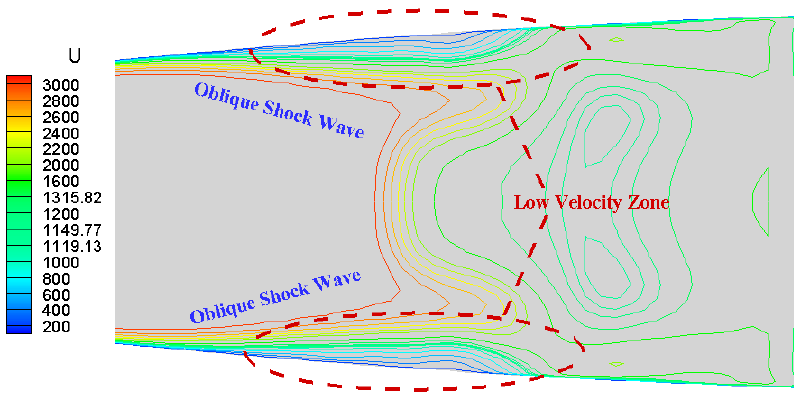
Figure 9. Low velocity zone and oblique shock.